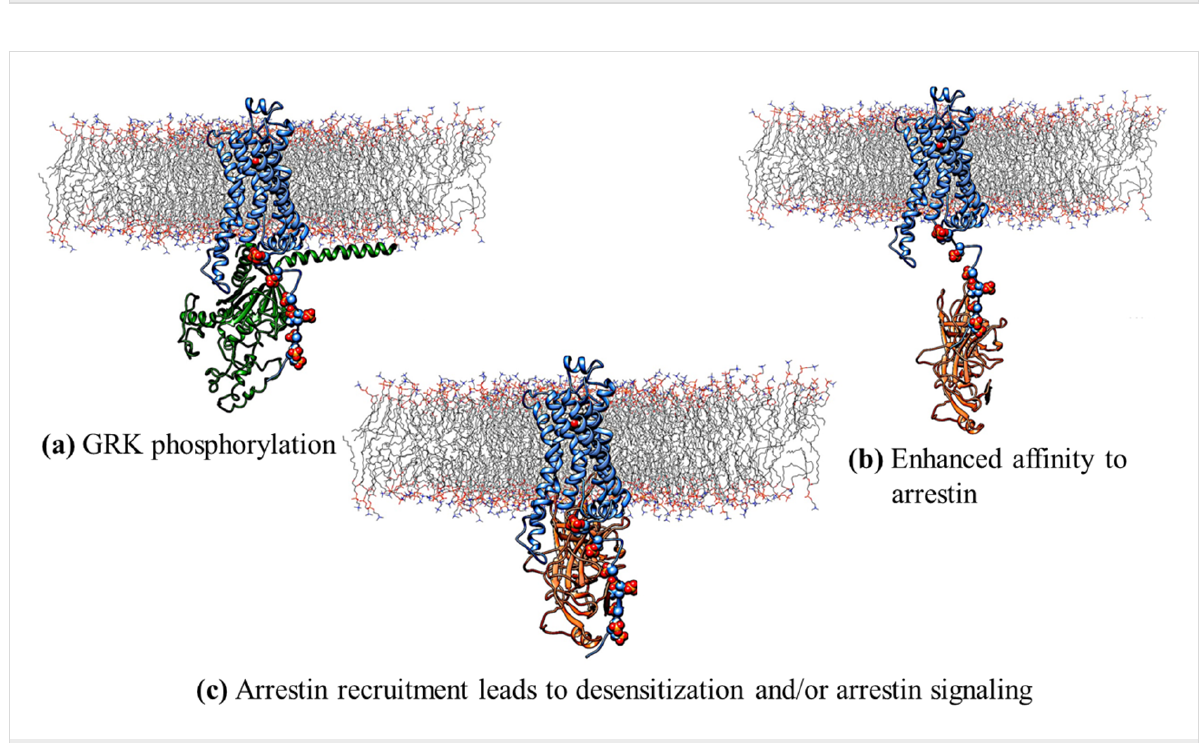
Figure 4: (a) After activation of the GPCR and dissociation of the β / γ subunits, IL3 and the C-terminus of the GPCR is phosphorylated by G-protein regulating kinases (GRKs). (b) Arrestin is recruited by the phosphorylated tail. (c) The fully bound arrestin can lead either to internalization of the re- ceptor (inactivation) or to a separate arrestin signaling path. This Figure represents only one of many possibilities, which have been reviewed by Tobin [19].